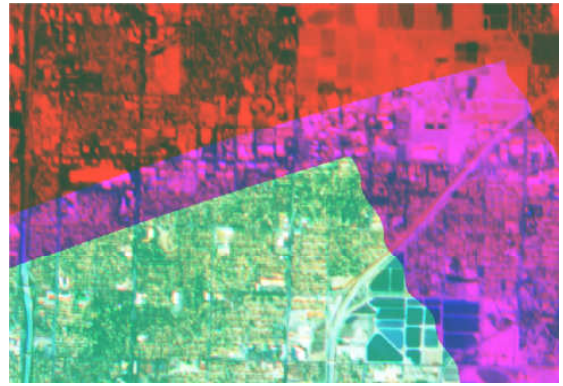
Figure 5. After adjustment: AirMSPI 660 nm Intensity layers (upper right corner) 1) Red: +60º, 2) Green: 0º, and 3) Blue: